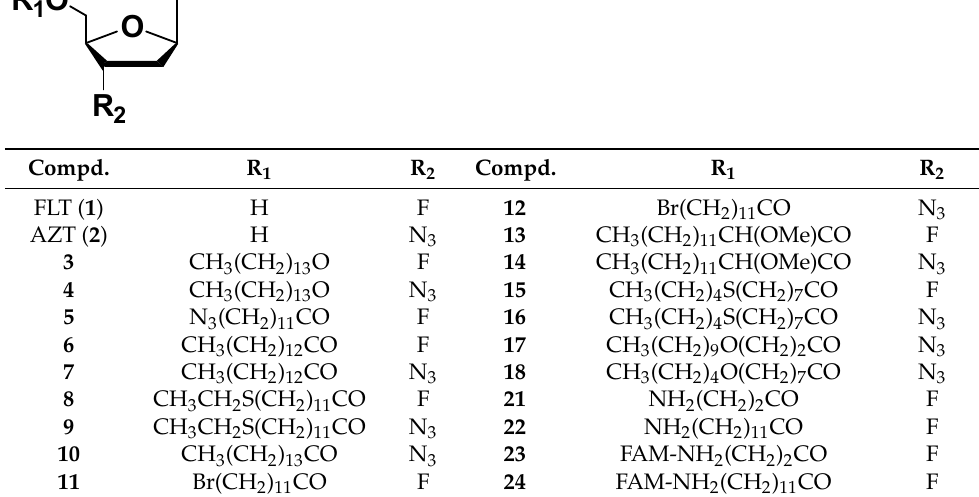
Table 1. Chemical structures of the 5 ′ - O -fatty ether and fatty acyl derivatives of AZT and FLT.